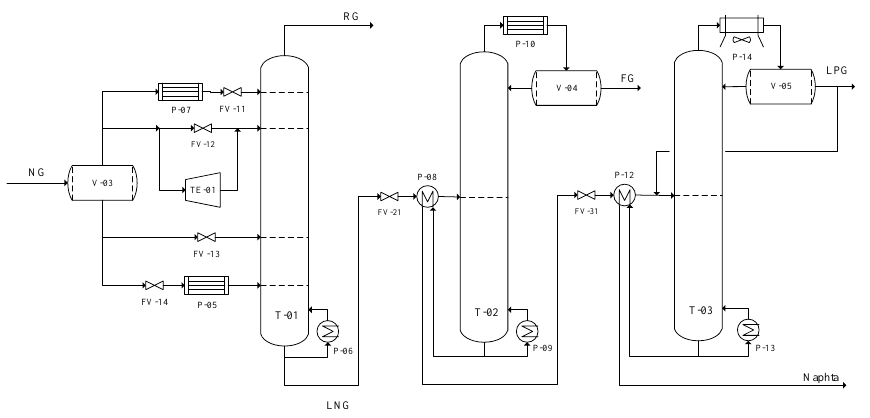
Figure 3. Simplified process flow diagram of the NGPU. V-03—feed accumulator vessel of the Demethanizer tower (T-01); FV-11/12/13/14—feed flow control valves of T-01; TE-01— turboexpander of T-01; P-05/07—heat exchanger of the cold-box of T-01; P-10—condenser of the Deethanizer tower (T-02); V-04—condenser accumulator vessel of T-02; P-14—condenser air-cooler of the Debutanizer tower (T-03); V-05—condenser accumulator vessel of T-03; P-06/09/13—reboiler heat exchangers of T-01/02/03; FV-21/31—feed flow control valves of T-02/03; P-08/12—feed heat exchanger of